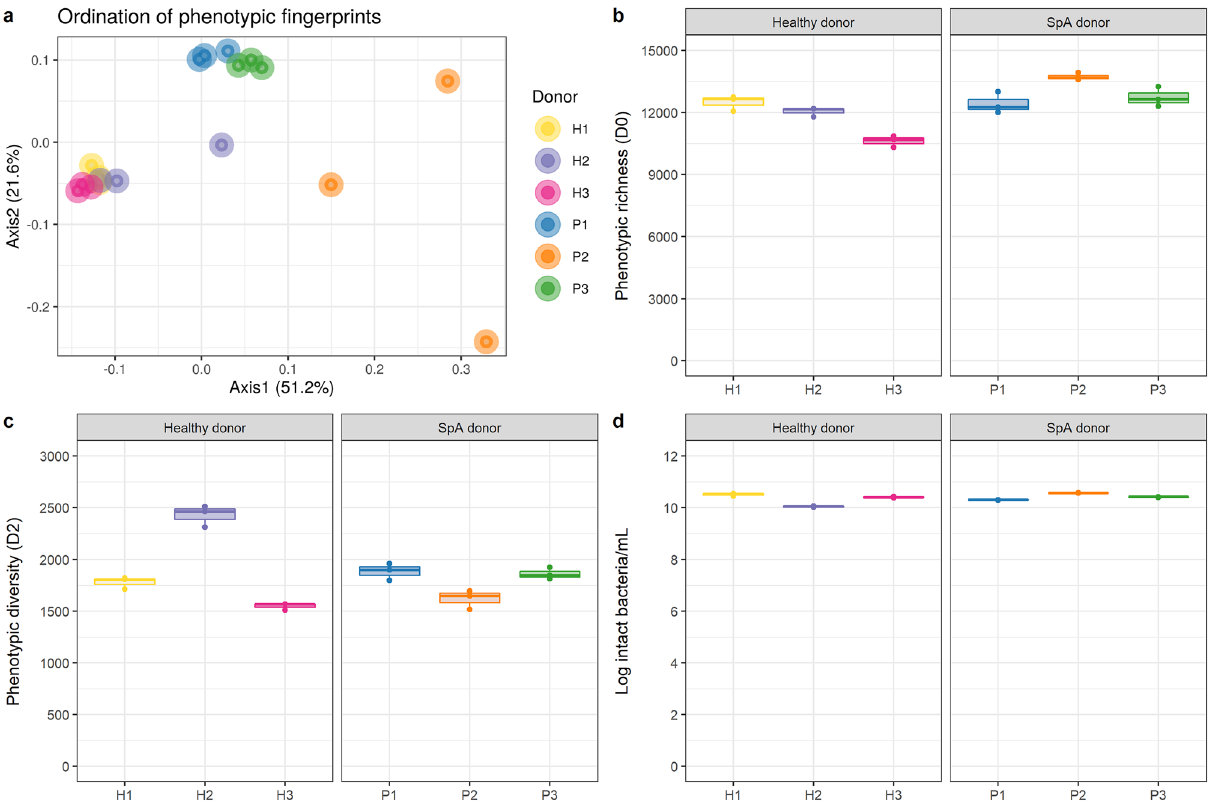
Figure 5. Flow cytometry fingerprinting and cell counting of fecal slurries at time point zero. ( a ) Phenotypic beta diversity displayed in a PCoA plot using Bray–Curtis distances. ( b ) Phenotypic richness (D0). ( c ) Phenotypic alpha diversity (D2). ( d ) Intact bacterial cell counts (n = 3).